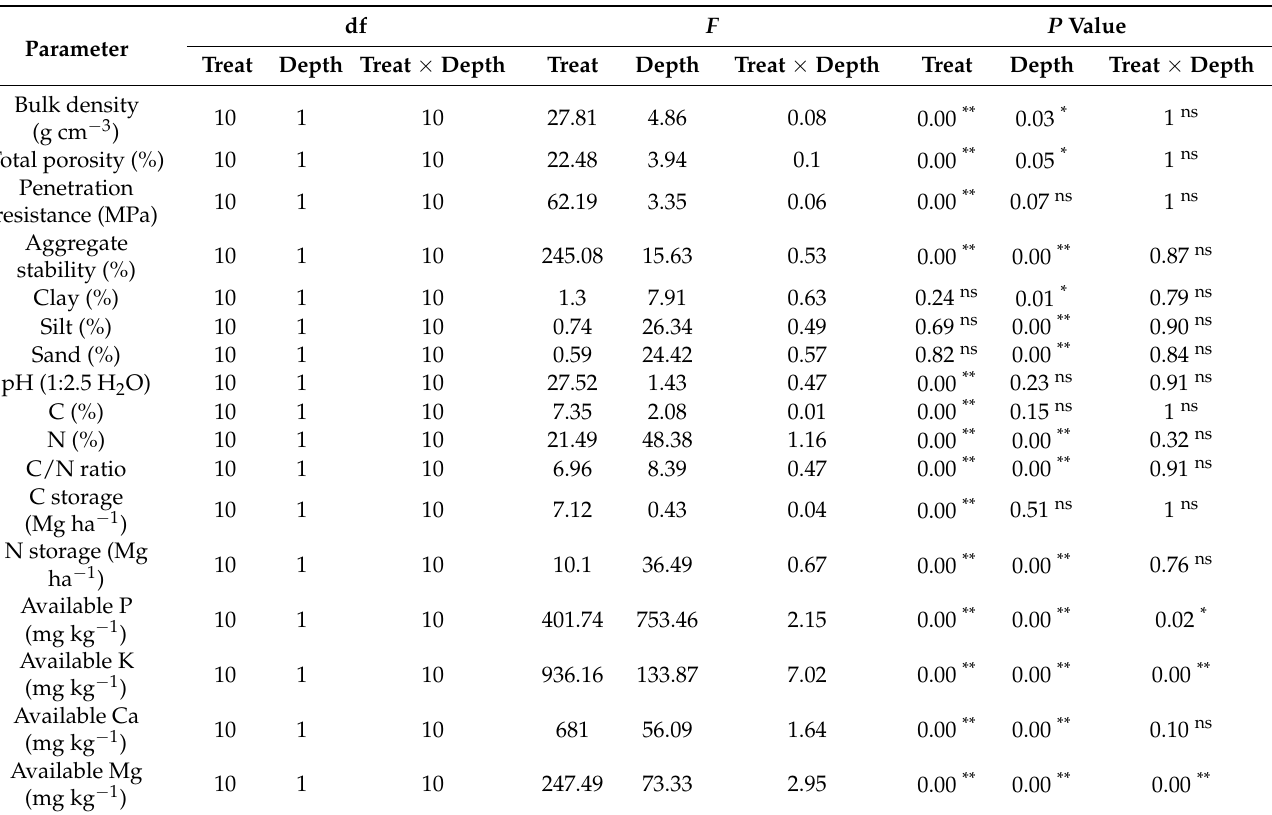
Results of ANOVA for the effect of treatment, soil depth and their interaction on soil physical and chemical